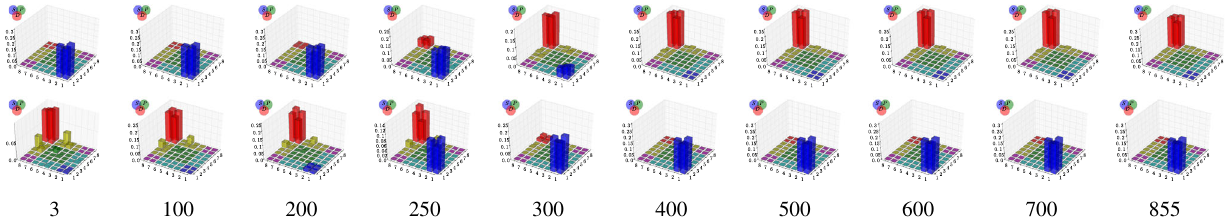
Fig. 10 Orbital angular momentum decompositions of first (lower row) and second (upper row) excitation in the 1 −− channel as functions of the current-quark or pion mass, respectively. The current-quark mass in MeV is given below each column. Axes and colors as in Fig.